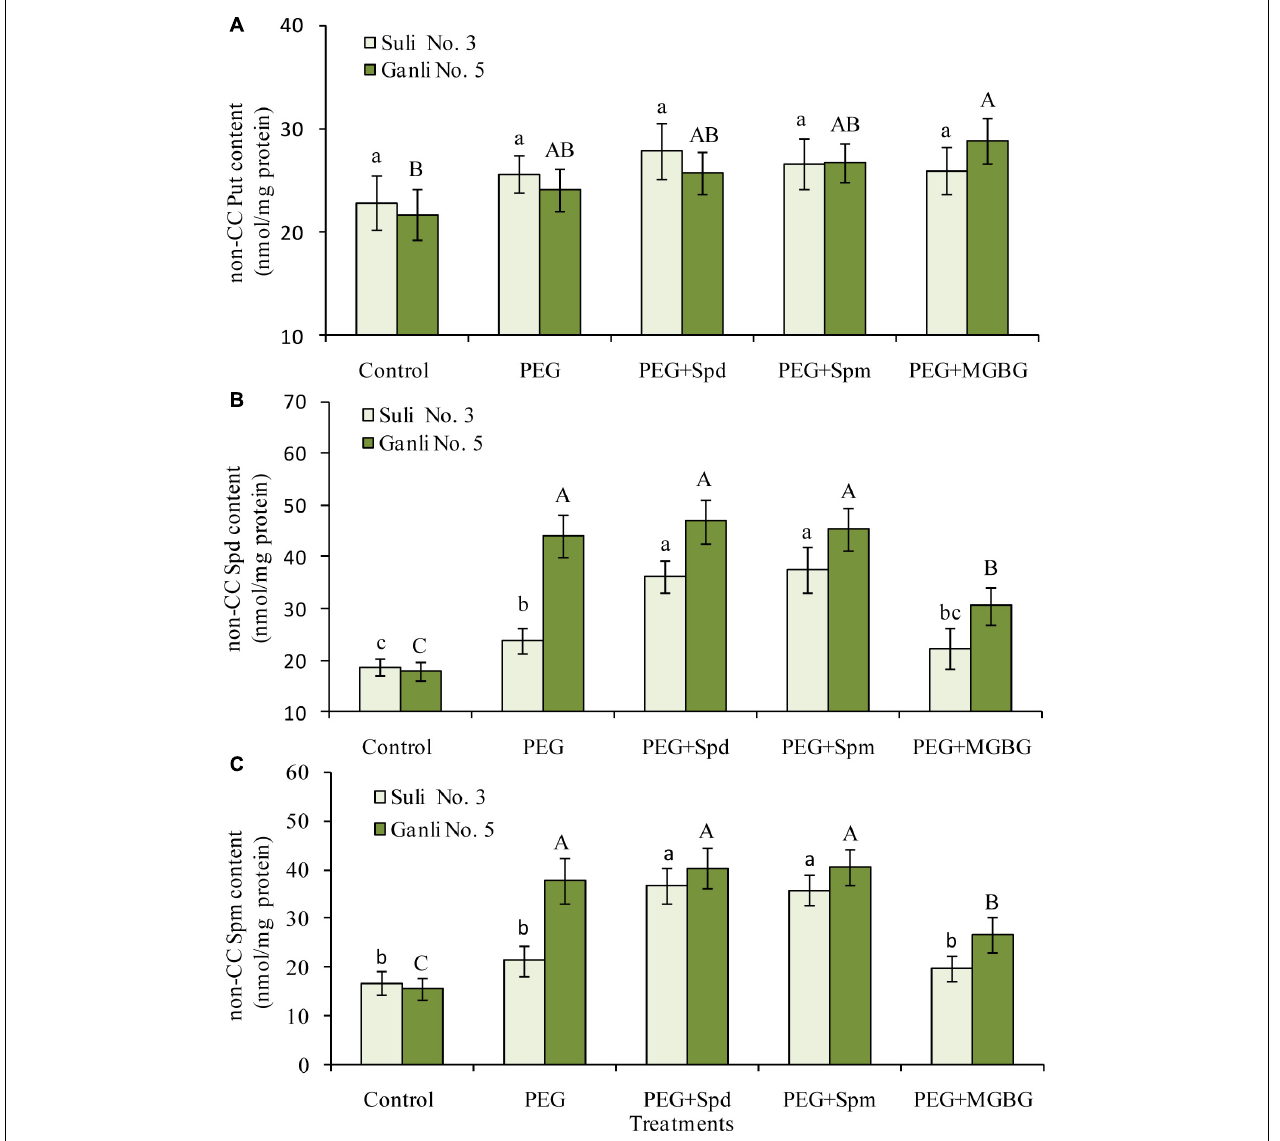
FIGURE 5 | Changes in the contents of non-CC Put (A) , non-CC Spd (B) , and non-CC Spd (C) in plasma membrane from plum seedling roots under PEG, exogenous Spd, Spm, and MGBG. Control: treatment without PEG or the other reagents (–0.15 MPa); PEG: treatment with PEG (–0.85 MPa); PEG + Spd: treatment with PEG and Spd (1 mM); PEG + Spm: treatment with PEG and Spm (1 mM); PEG + MGBG: treatment with PEG and MGBG (0.5 mM). The data here were means ( n = 9) ± standard error of 3 independent experiments. Significant differences between treatments are indicated with letters, with upper and lower letters for each cultivar ( P <